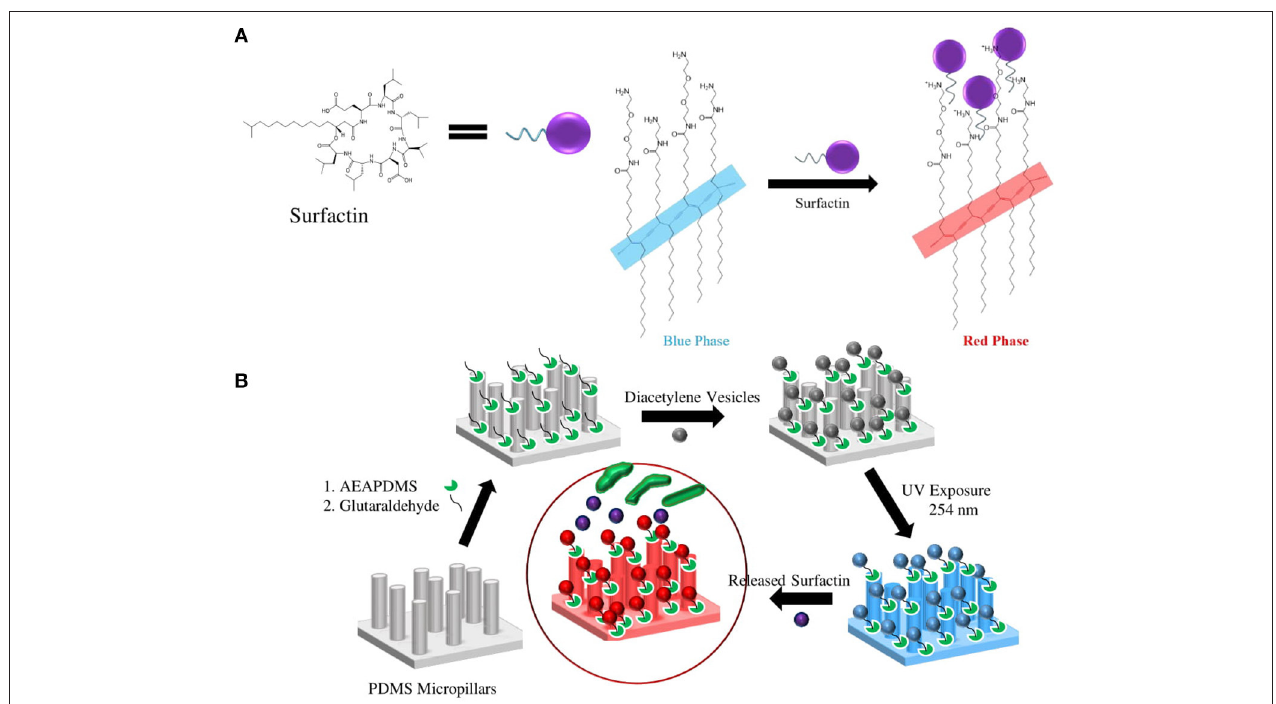
FIGURE 4 | Schematic of (A) PDA-surfactin interaction through the ionic interaction between the hydrophilic head of surfactin and amine group of PDA and fatty acid chain of surfactin with carbon backbones in PDA, (B) procedure of surface modifications and immobilization of PCDA on the PDMS micropillars.